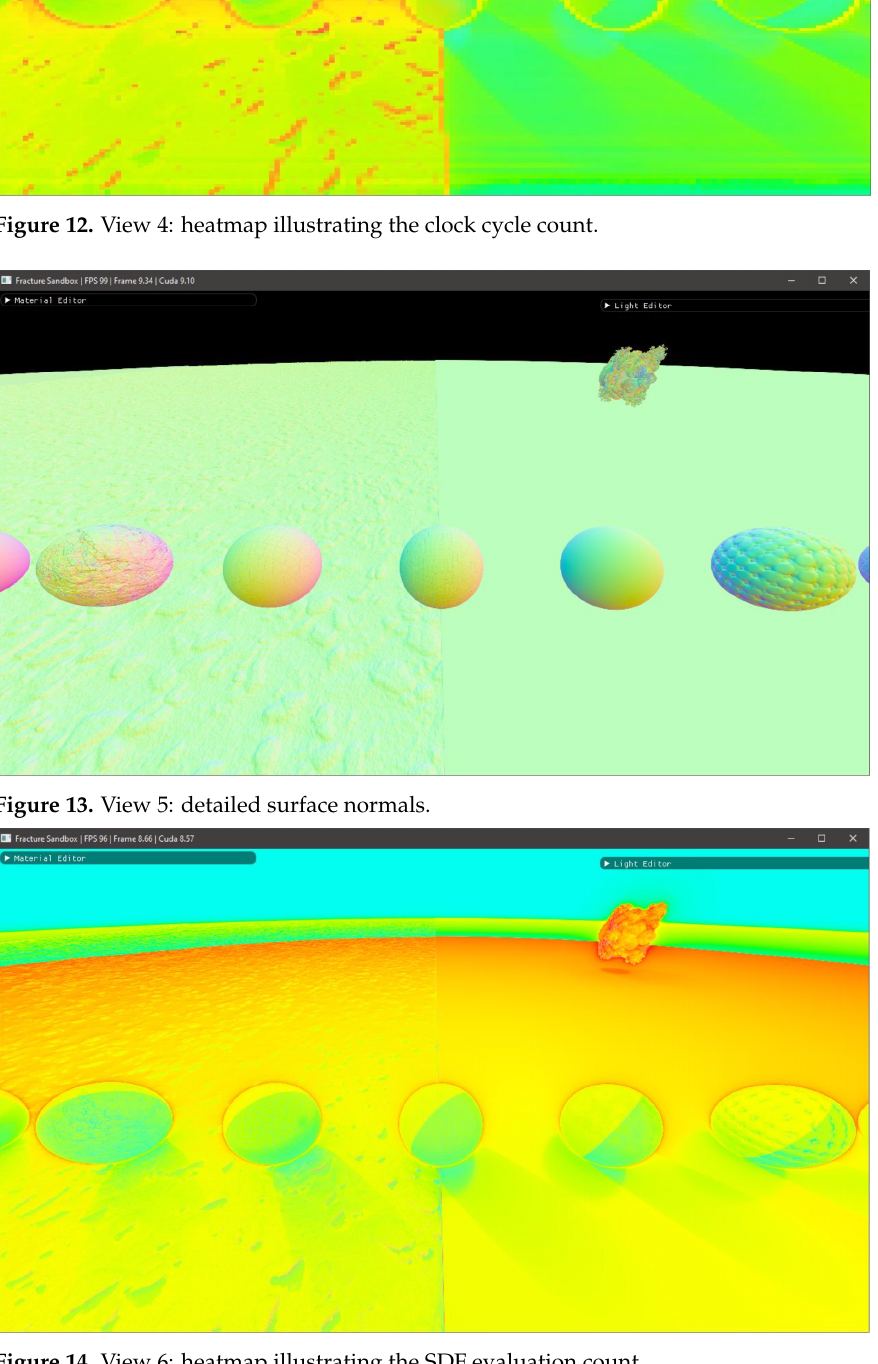
Figure 14. View 6: heatmap illustrating the SDF evaluation